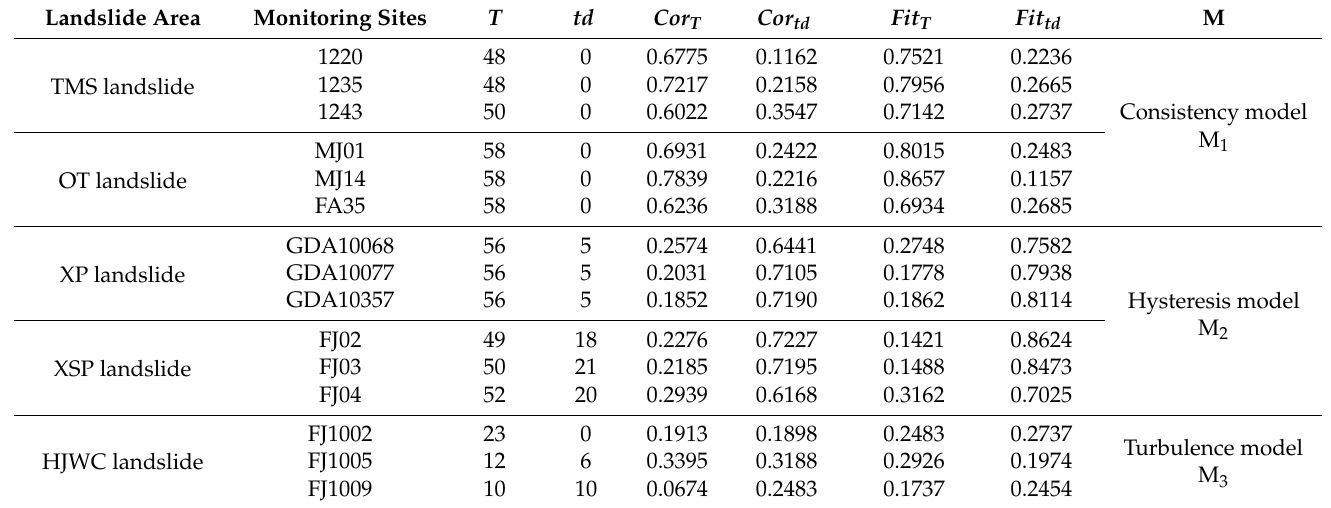
Table 4. Table of quantitative analysis results of monitoring points in the landslide